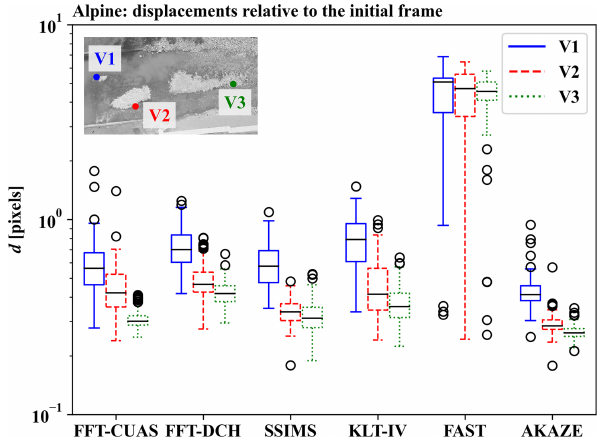
Figure 11. Displacements of validation points relative to their posi- tions in the initial frame for the Kolubara river case study.